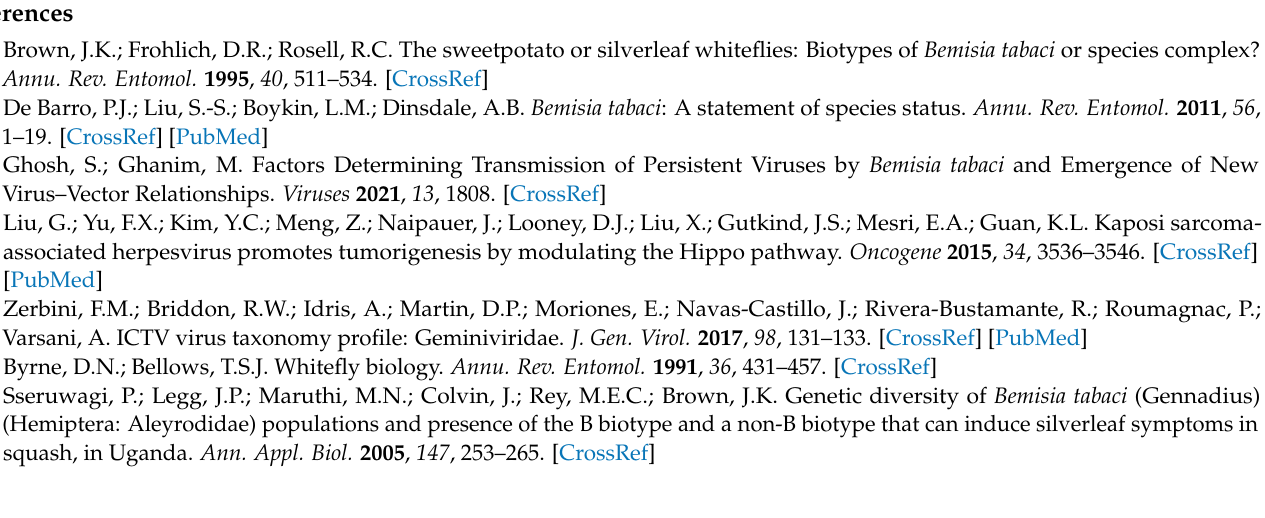
network analysis. Figure S2: SiGMV weighted gene co-expression network analysis. Figure S3: CuLCrV weighted gene co-expression network analysis. Table S1: Endpoint PCR and qPCR primers used in this study. Table S2: Pearson’s correlation coefficients for multiple biological replicates. Table S3: RT-qPCR concordant validation for selected differentially expressed genes from RNA- Seq data. Table S4: KEGG annotations and pathway analysis for differential expressed genes in viruliferous versus non-viruliferous